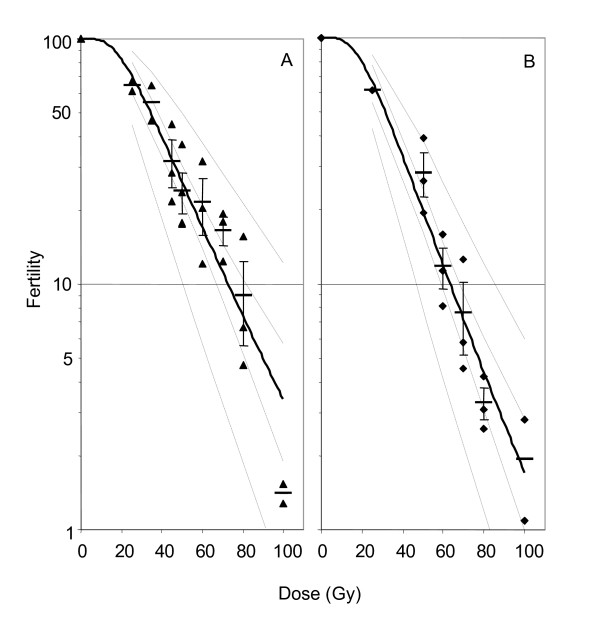
Regression line (± 95% CI for mean and individual values) for fertility versus irradiation dose (Gy) for male An. arabiensis pupae (A) and adults (B). Symbols indicate observed individual values. Means (± SE, if n>2) are indicated by a horizontal line.